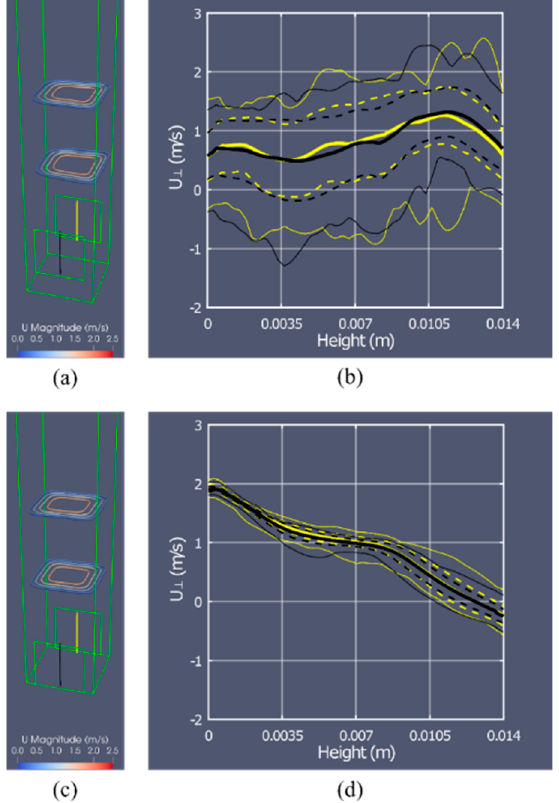
Figure 4. Fluid velocity structure inside the nozzle: ( a ) Velocity magnitude contours for type A NIP; ( b ) Time averaged port-perpendicular velocity components along both ports for type A NIP; ( c ) Velocity magnitude contours for type B NIP; ( d ) Time averaged port-perpendicular velocity components along both ports for type B NIP. Panels ( a , c ) also show the paths (black and yellow lines) along which the velocity profiles shown in panels ( b , d ) were extracted. See the text for details.